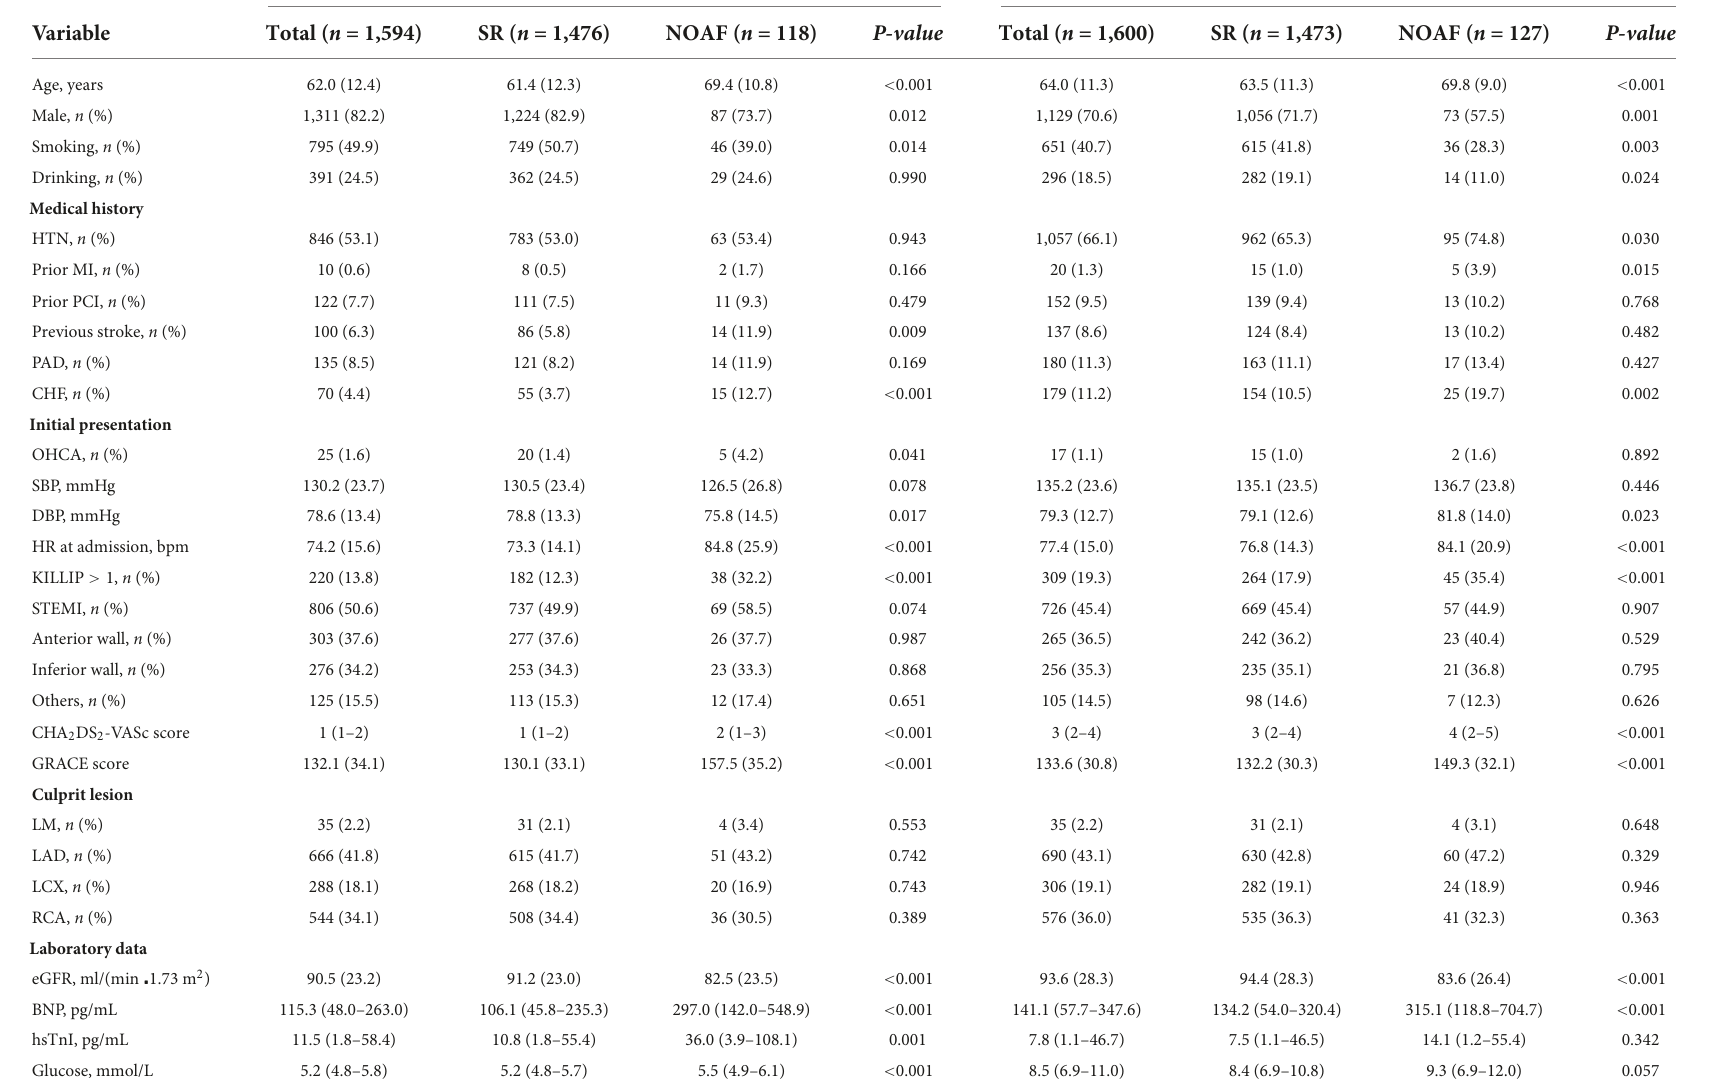
TABLE 1 Baseline